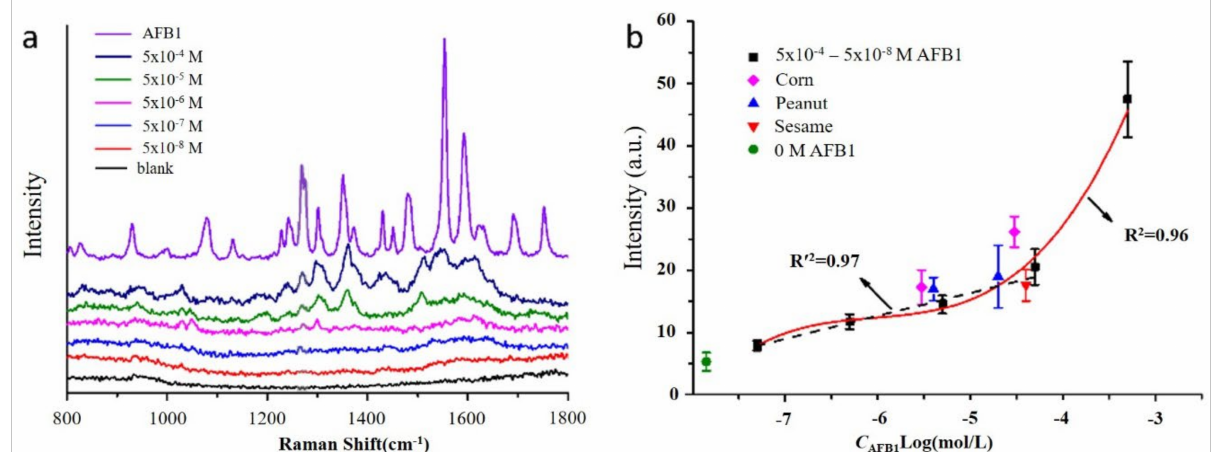
Figure 6. ( a ) Raman spectra of AFB1 with different concentrations in the optimized coffee ring substrate. ( b ) Semi-log plot of the peak intensity as a function of AFB1 concentration for the peak of 1275 cm − 1 . The data were collected from the DXR Smart Raman spectrometer: (Thermo Fisher Scientific, Waltham, MS, USA) excitation wavelength, 780 nm; maximum excitation power, 80 mw; integration time 15